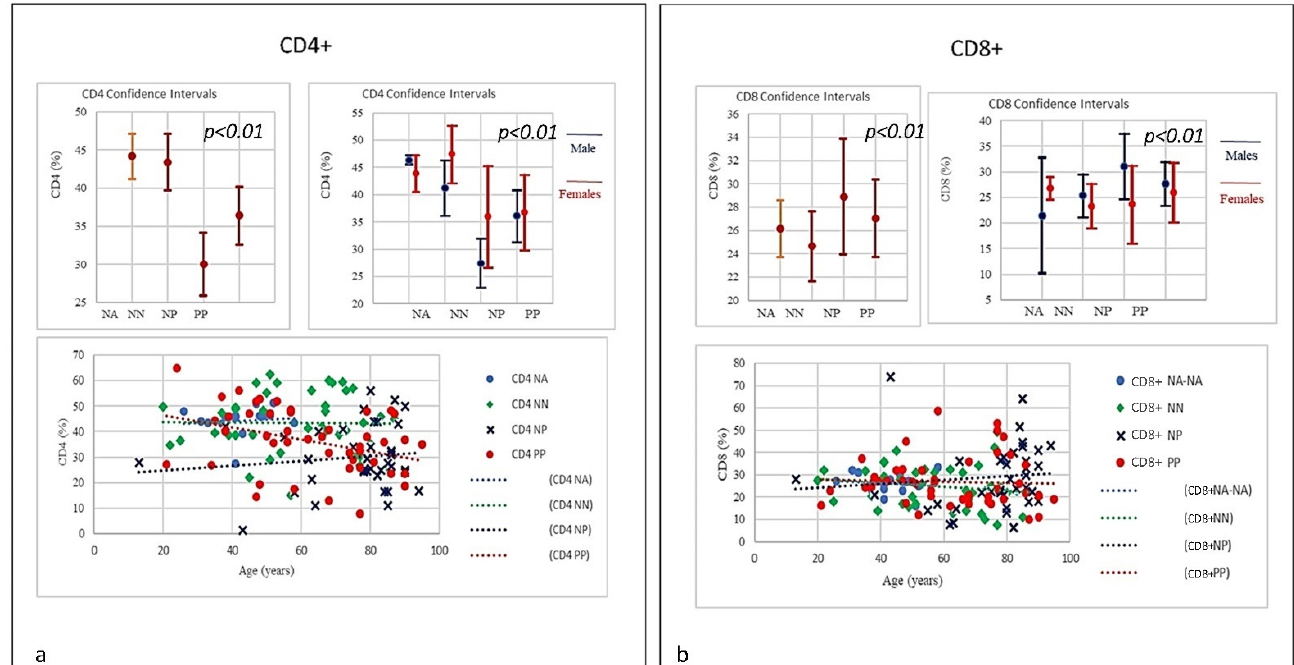
Figure 3. ( a ) Frequencies of CD4+ lineage in COVID-19 patients and controls (NP, NN and NA). A negative correlation was observed between the age and the percentage of T CD4 between PP and NP. PP patients T CD4 levels from a normal range tend to decline with age, conversely NP showed an increasing trend starting from lower range level and increasing with age ( p < 0.001). ( b ) Frequencies of CD8+ lineage in COVID-19 patients and controls (NP, NN and NA). The CD8 did show a quantitative increase correlated with age in NP group (the older the higher). Conversely a slightly quantitative decrease in PP and NN groups was seen correlated with age (the older the lesser).